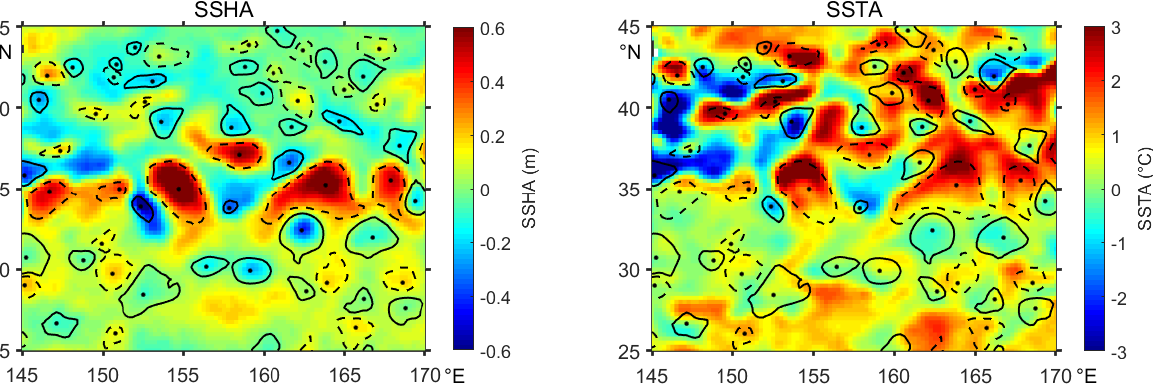
Figure 2. Maps of SSHA ( left ) and SSTA ( right ) on 4 January 2010 in the Kuroshio Extension; the solid and dashed lines represent cyclonic and anticyclonic eddies identified from SSHA field.